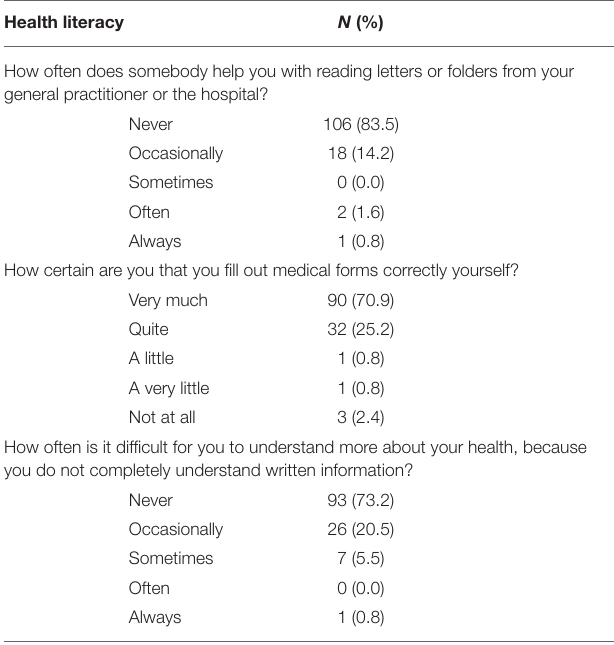
TABLE 3 | Health Literacy questions and outcome. Health